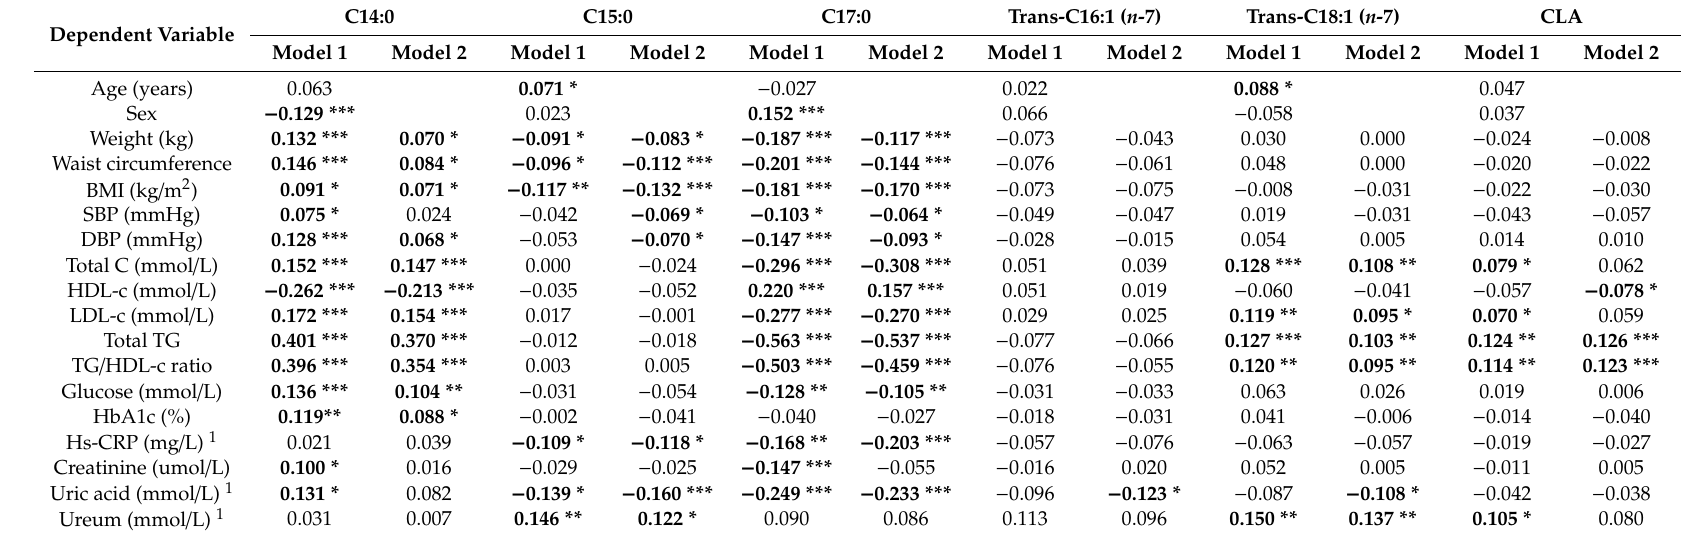
Table 2. Association between circulating fatty acid markers from plasma triglycerides (TG) and cardiovascular risk